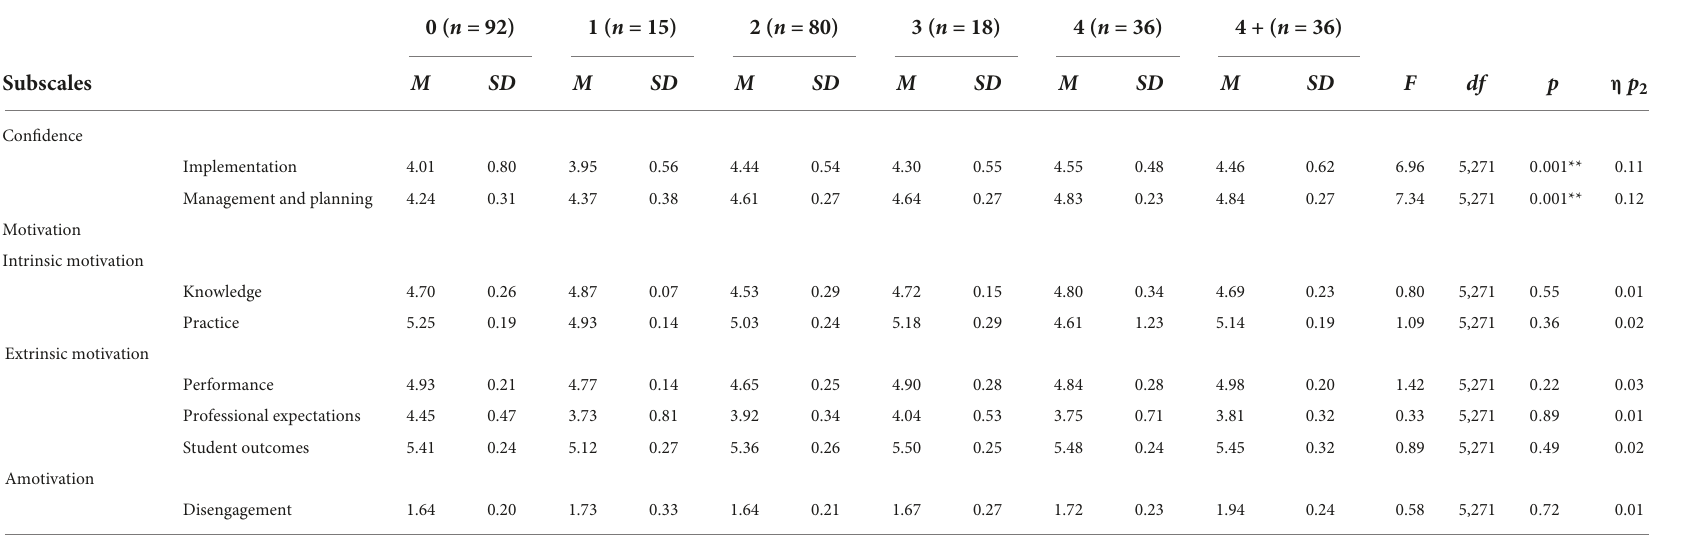
TABLE 6 Descriptive statistics and ANOVA results for confidence and motivation by units of physical education